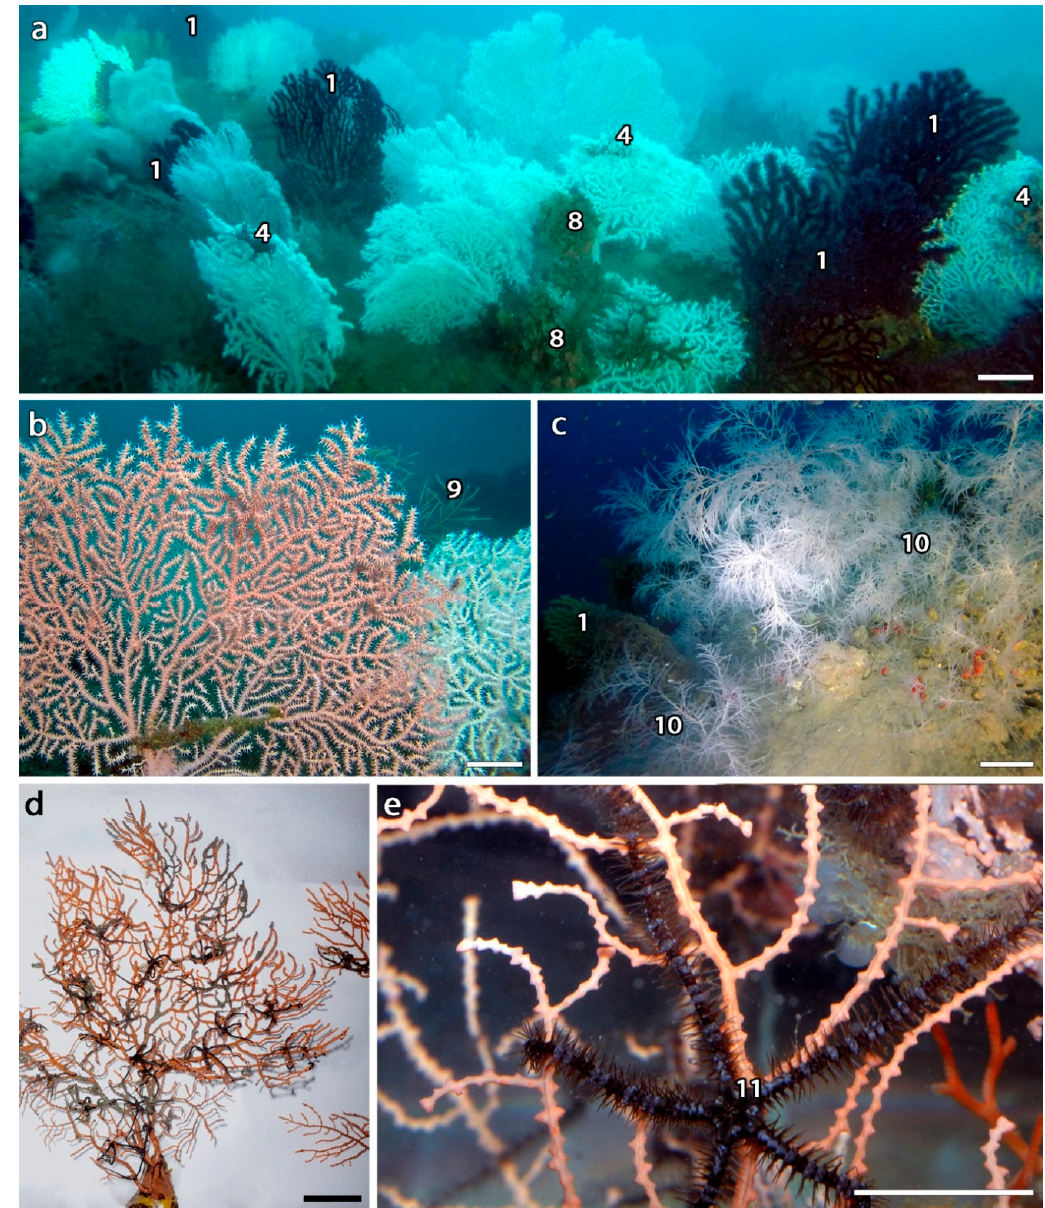
Figure 4. Additional records of Eunicella verrucosa . ( a ) Mixed forest of E. verrucosa and Paramuricea clavata (1) off Bordighera, with colonies epibionted by the ophiuroid Astrospartus mediterraneus (4) and by bryozoans (8); ( b ) detail of both pink and white morphotypes of E. verrucosa ; in the background, a colony of Leptogorgia sarmentosa (9); ( c ) mixed forest of P. clavata (1) and Antipathella subpinnata (10) off Bordighera; ( d ) colonies of E. verrucosa sampled southeast of Kotor, with many epibiont ophiuroids Ophiacantha setosa ; ( e ) detail of the colony with O. setosa (11). Scale bars: a,c, 10 cm; b,d–e, 5 cm.